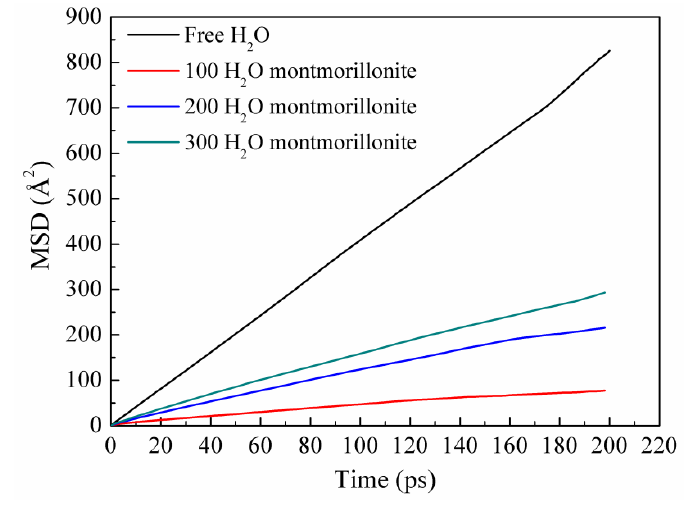
Figure 13. Mean square displacement (MSD) of free water and structural water in montmorillonite layers. Table 4. Calculated diffusion coefficient of free water and structural water in montmorillonite.